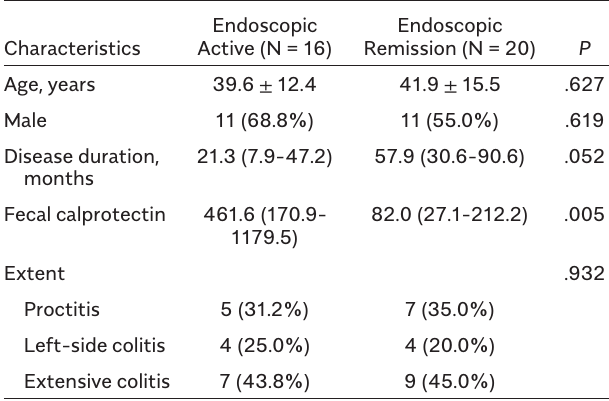
Supplementary Table 3. Comparison of Those with Sustained Endoscopic Activity and Endoscopic Remission Among Patients